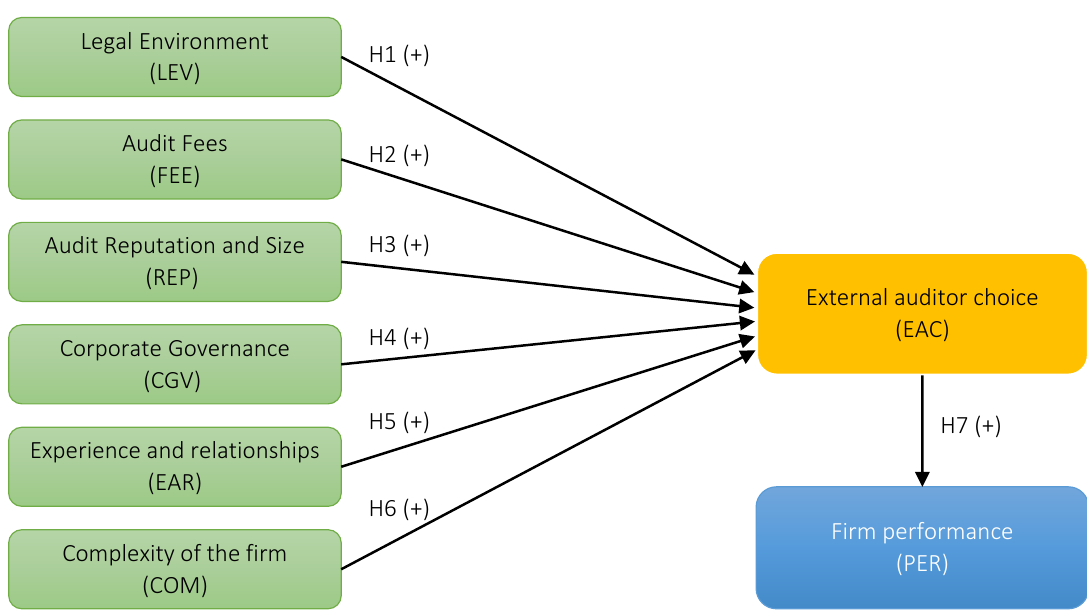
Figure 1. Conceptual research model for commercial banks in